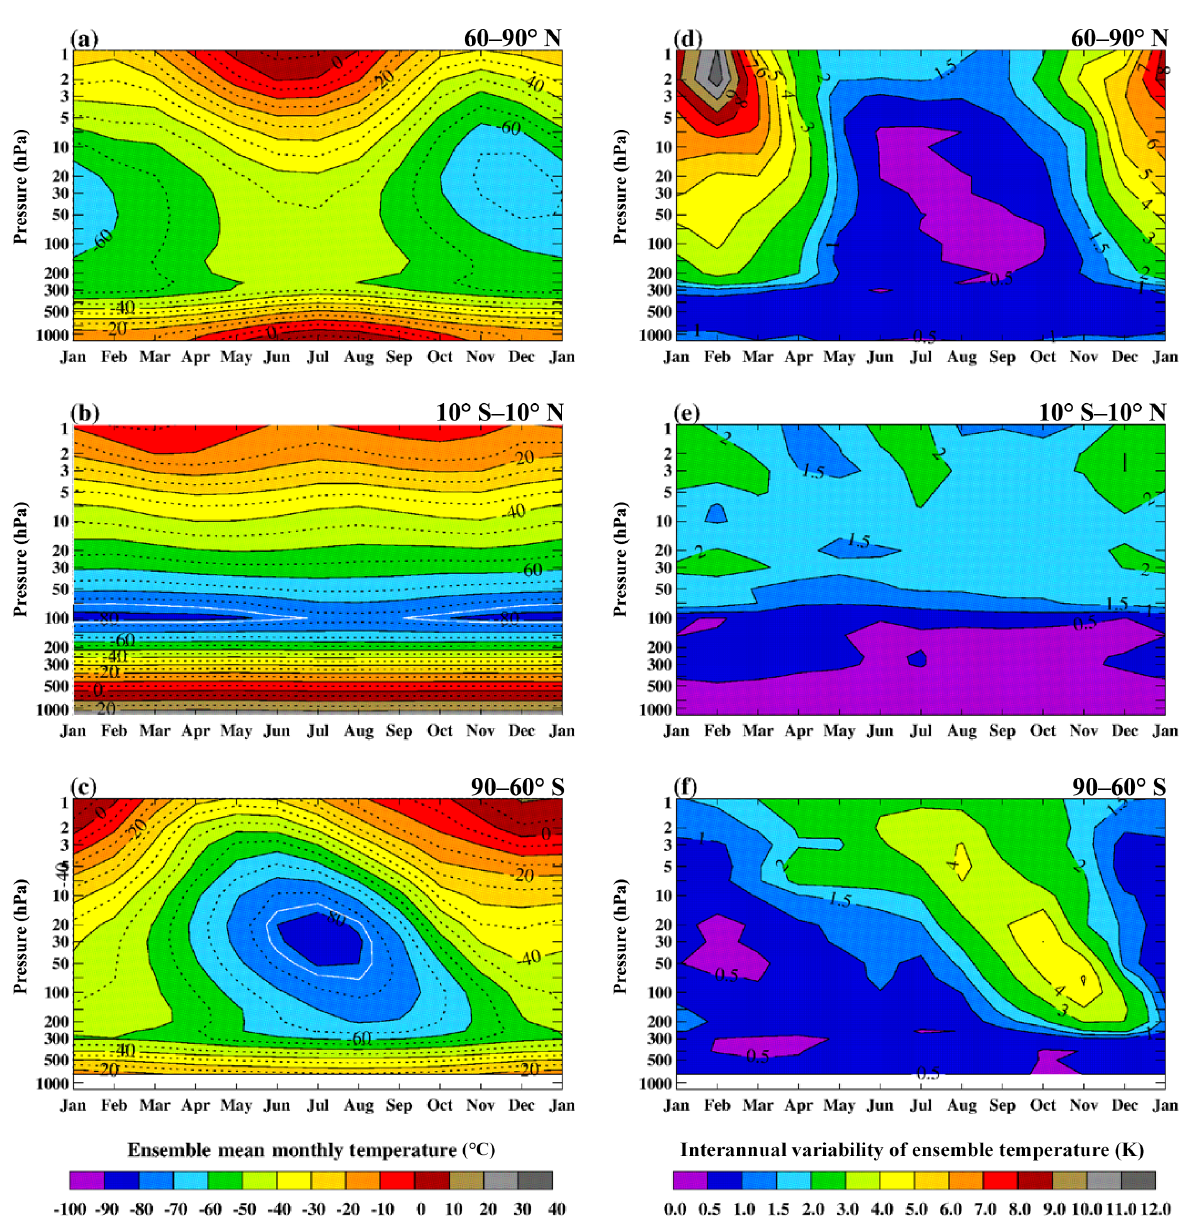
Figure 2. Annual variation in the REM temperature monthly means ( ◦ C) and their SD (K) in three different zonal regions: 60–90 ◦ N (a, b) , 10 ◦ S–10 ◦ N (c, d) , and 90–60 ◦ S (e, f)